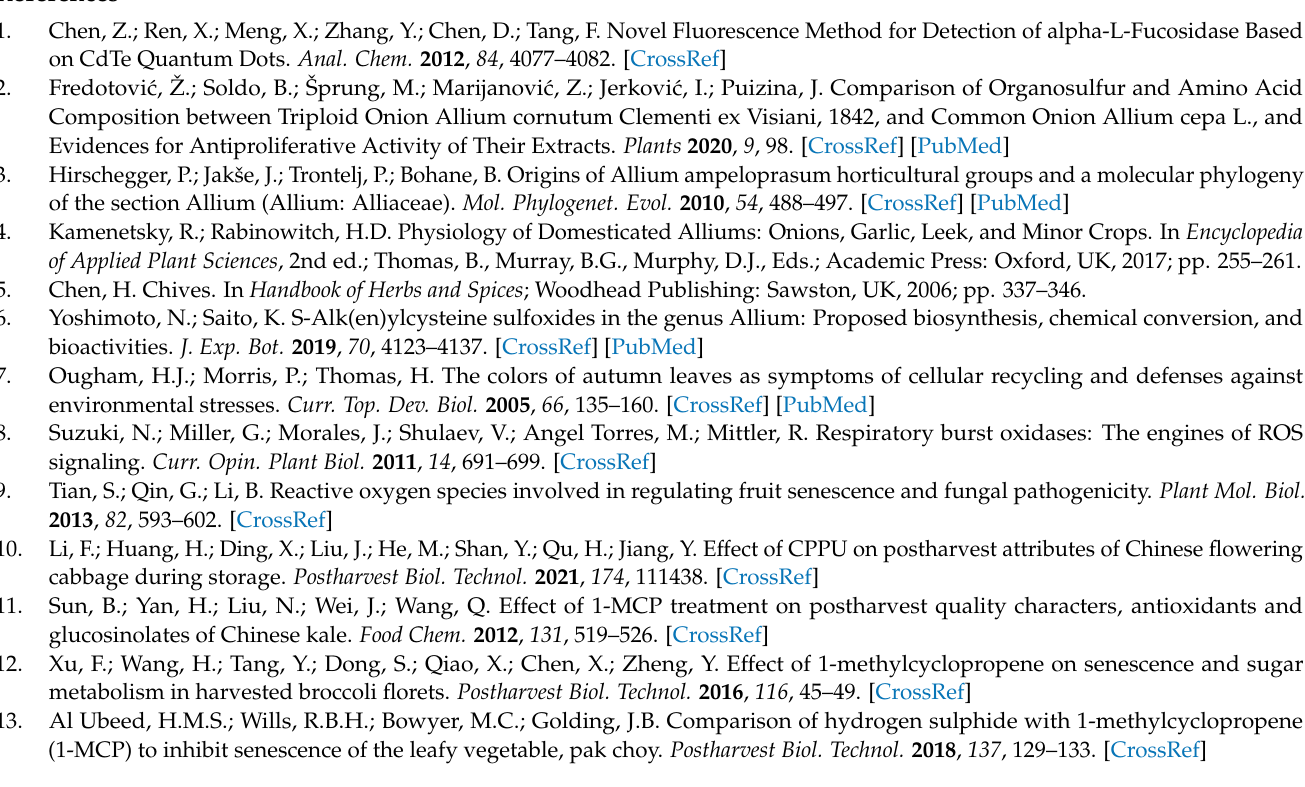
Figure S2: Asn content (A), Gln content (B), Ser content (C), Arg content (D), Thr content (E), Ala content (F), Val content (G), Trp content (H), Leu content (I), Phe content (J), Pro content (K) and Met content (L) in 1-MCP treated chives and untreated chives during storage at 20 o C and 3 o C. The content of free amino acids in 1-MCP treated chives stored at 3 o C were not determined. Data are expressed as the mean of triplicate samples. Vertical bars represent the standard errors of the means. the chive samples